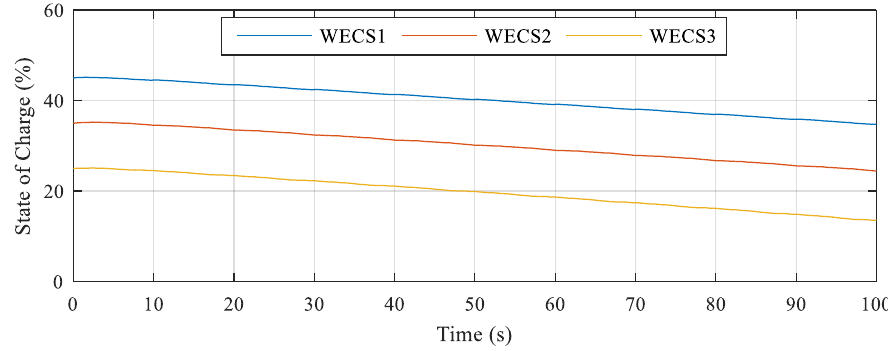
Figure 7. State of charge (SOC) of batteries in the WECS without proposed controller (Case 1).